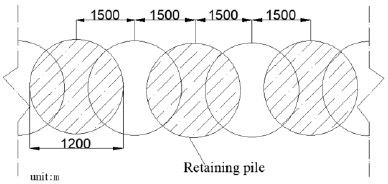
Figure 3. Schematic diagram of the retaining piles.